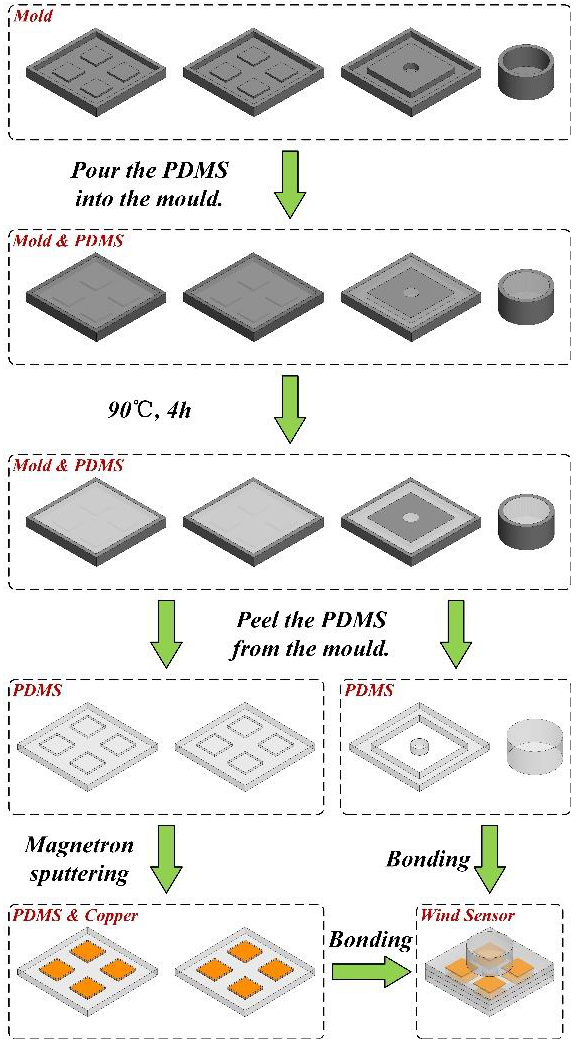
Figure 6. Fabrication process of the proposed flexible wind sensor. Photographs of the fabricated wind sensor, as well as each layer, are shown in Figure 7. The dimensions of the sensor are close to 40 mm × 40 mm × 19 mm. Due to errors in the fabrication process, such as nonuniform gaps between copper electrodes, the four capacitors (C 1 , C 2 , C 3 and C 4 ) show different initial capacitances without external force, which are measured to be about 1.099, 1.085, 1.113, and 1.105 pF, respectively.